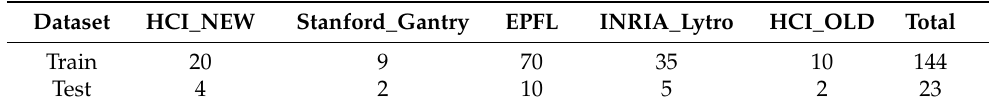
Table 1. Datasets used in our